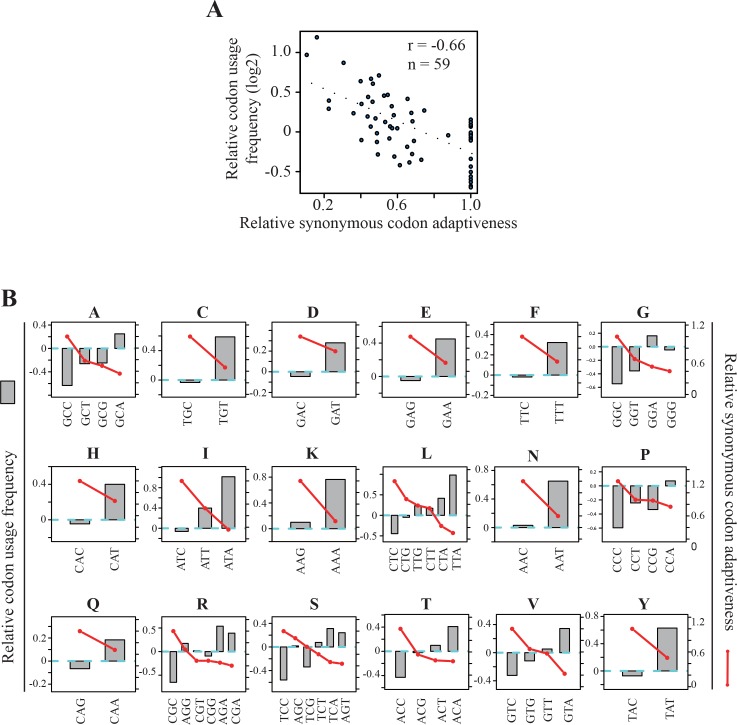
Correlations between relative codon usage frequency and relative synonymous codon adaptiveness.(A) Scatter plot analysis of relative codon usage frequency (RCUF) with relative synonymous codon adaptiveness (RSCA) of all codons with at least two synonymous codons in Neurospora. r = −0.66, p=5.5 × 10−9, n = 59. (B) The correlation of relative codon usage frequency (RCUF) with relative synonymous codon adaptiveness (RSCA) within each synonymous codon group with at least two codons in Neurospora.